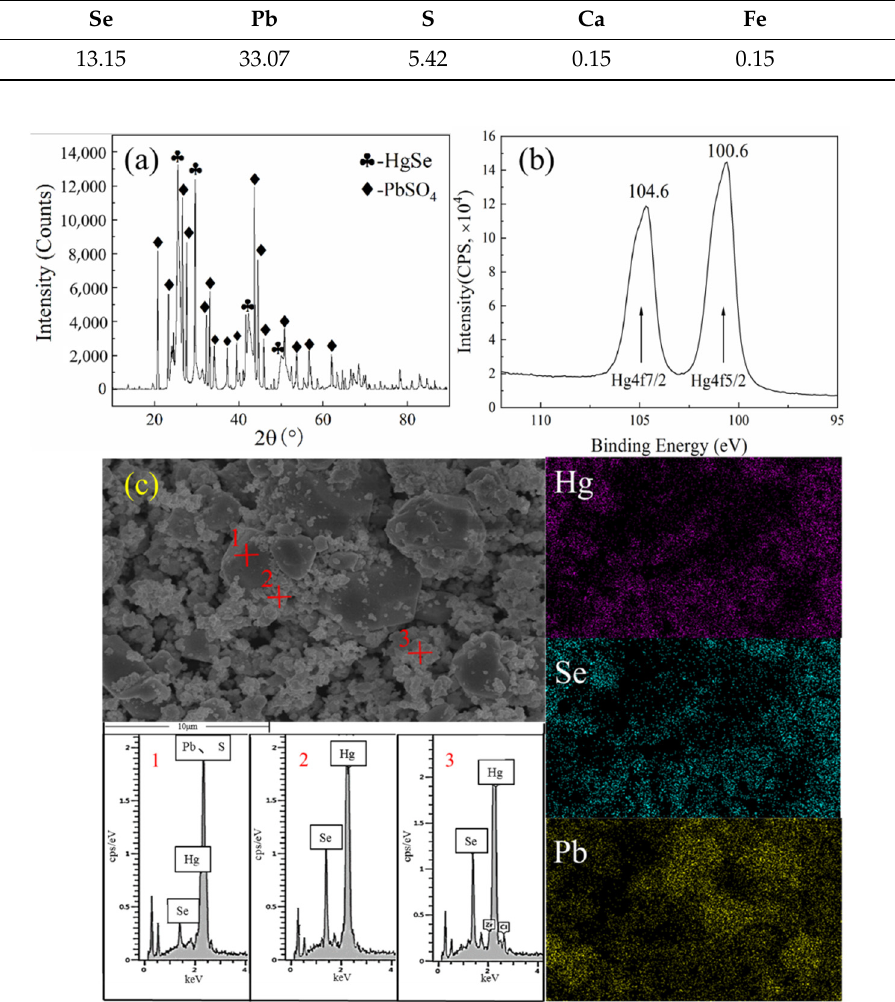
Figure 2. MAM characterization results: ( a ) XRD patterns of MAM; ( b ) Hg 4f XPS detailed spectrum of MAM; ( c ) FESEM-EDS images of MAM.